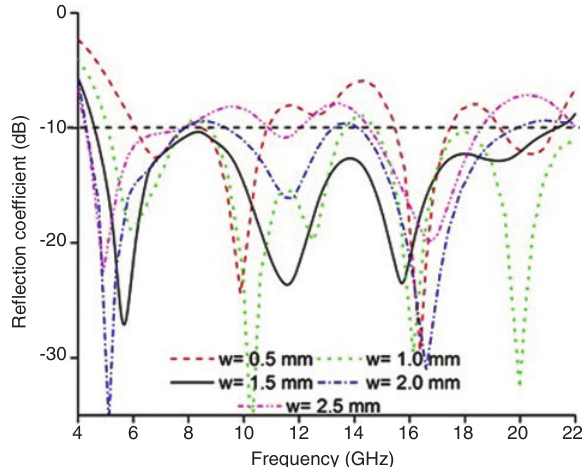
Figure 10: Prototype of the proposed